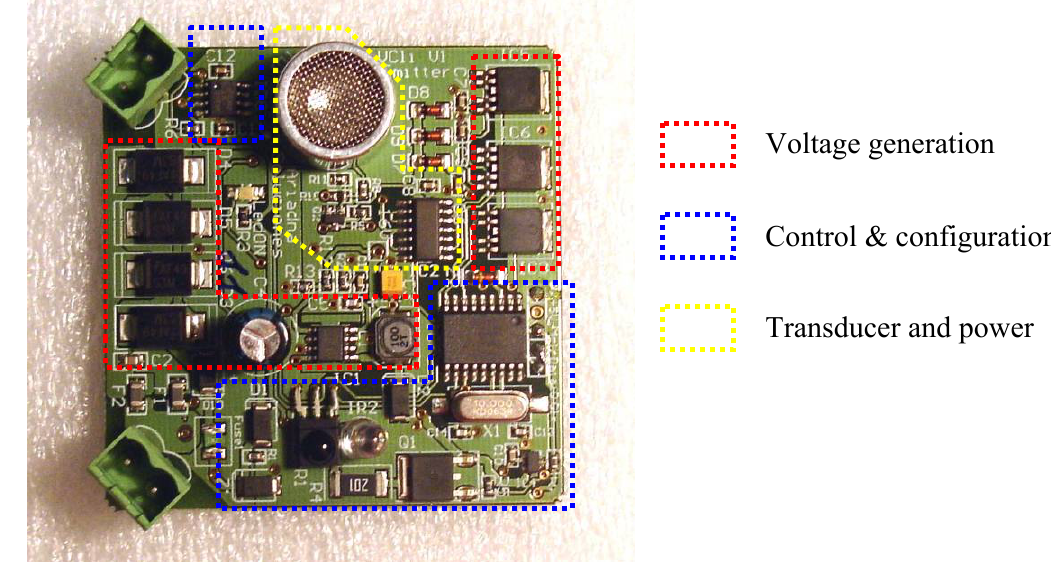
Figure 14 . Ultrasound emitter PCB Layout